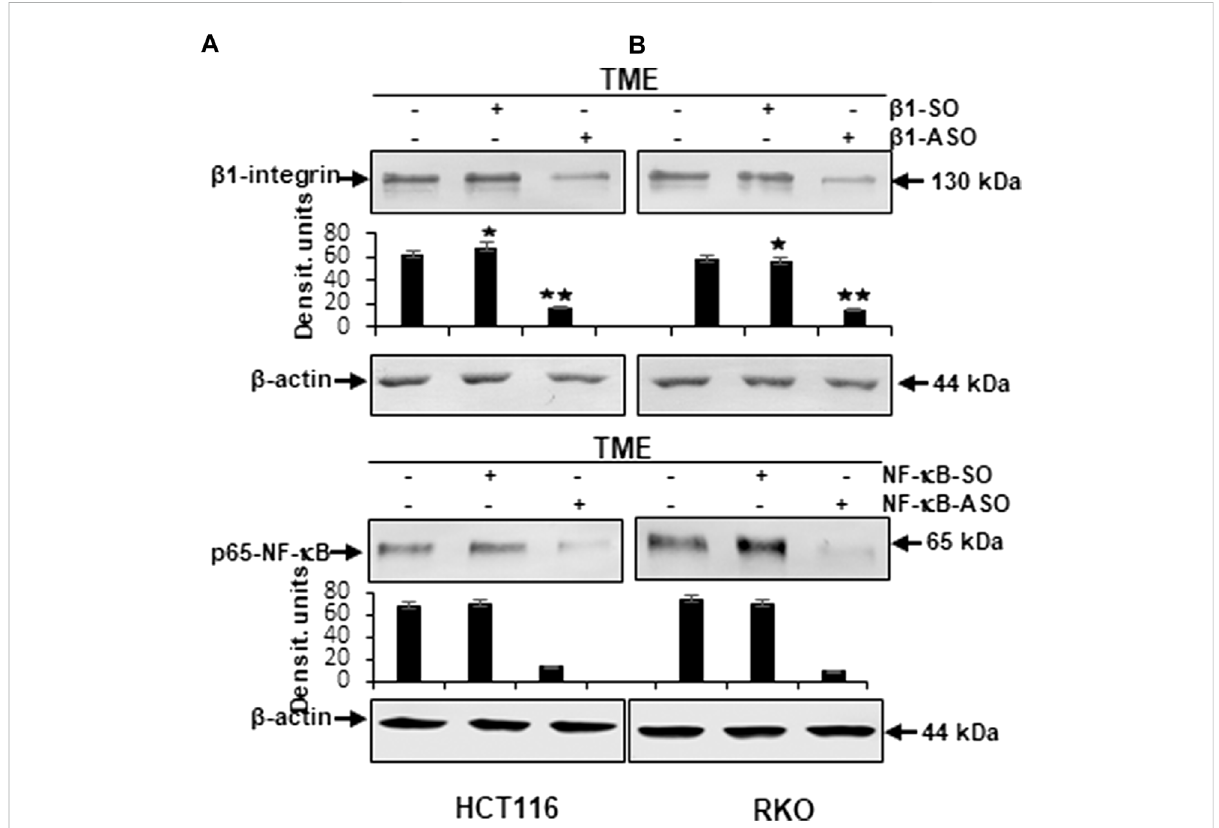
FIGURE 7 Western blot investigation on the ef fi cacy of β 1-integrin and NF- κ B knockdown by antisense oligonucleotides in CRC cells. X -axis: HCT116 (A) andRKO (B) samplesfrom3D-alginateTMEwereuntreatedortreatedwith β 1-SO/NF- κ B-SO or β 1-ASO/NF- κ B-ASO(0.5 µM).Immunoblotting with anti- β 1-integrin or with anti-p-65-NF- κ B and β -actin as a loading control. Y -axis: Densitometric units ( y -axis) complementing Western blot results. Statistical analysis: * p < 0.05 and ** p < 0.01, comparison to TME